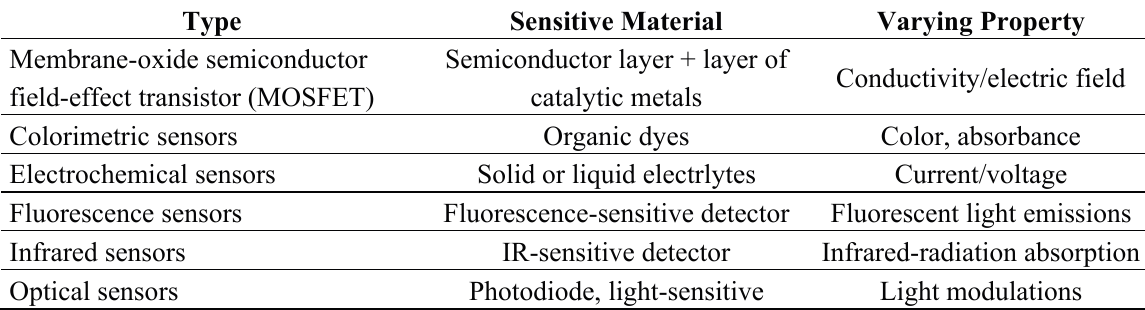
Table 1. Sensor types used in electronic nose